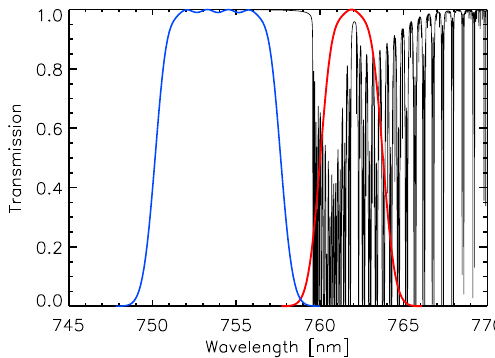
Figure 1. Spectral response functions for MERIS window channel 10 (blue) and MERIS channel 11 in the oxygen-A absorption band (red). Black lines: oxygen absorption